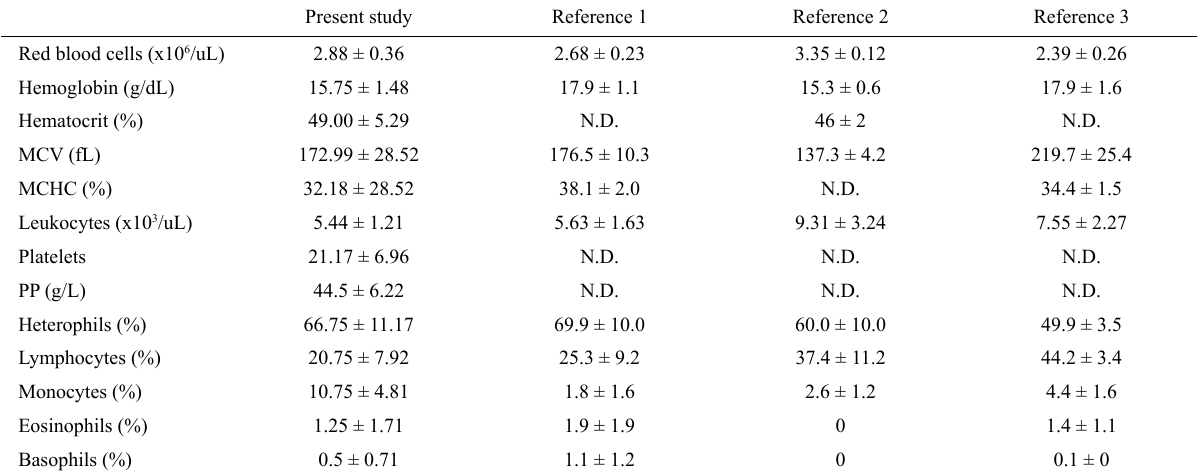
Table 2 - Hematological values for Falco peregrinus and reference ranges of falcons from the